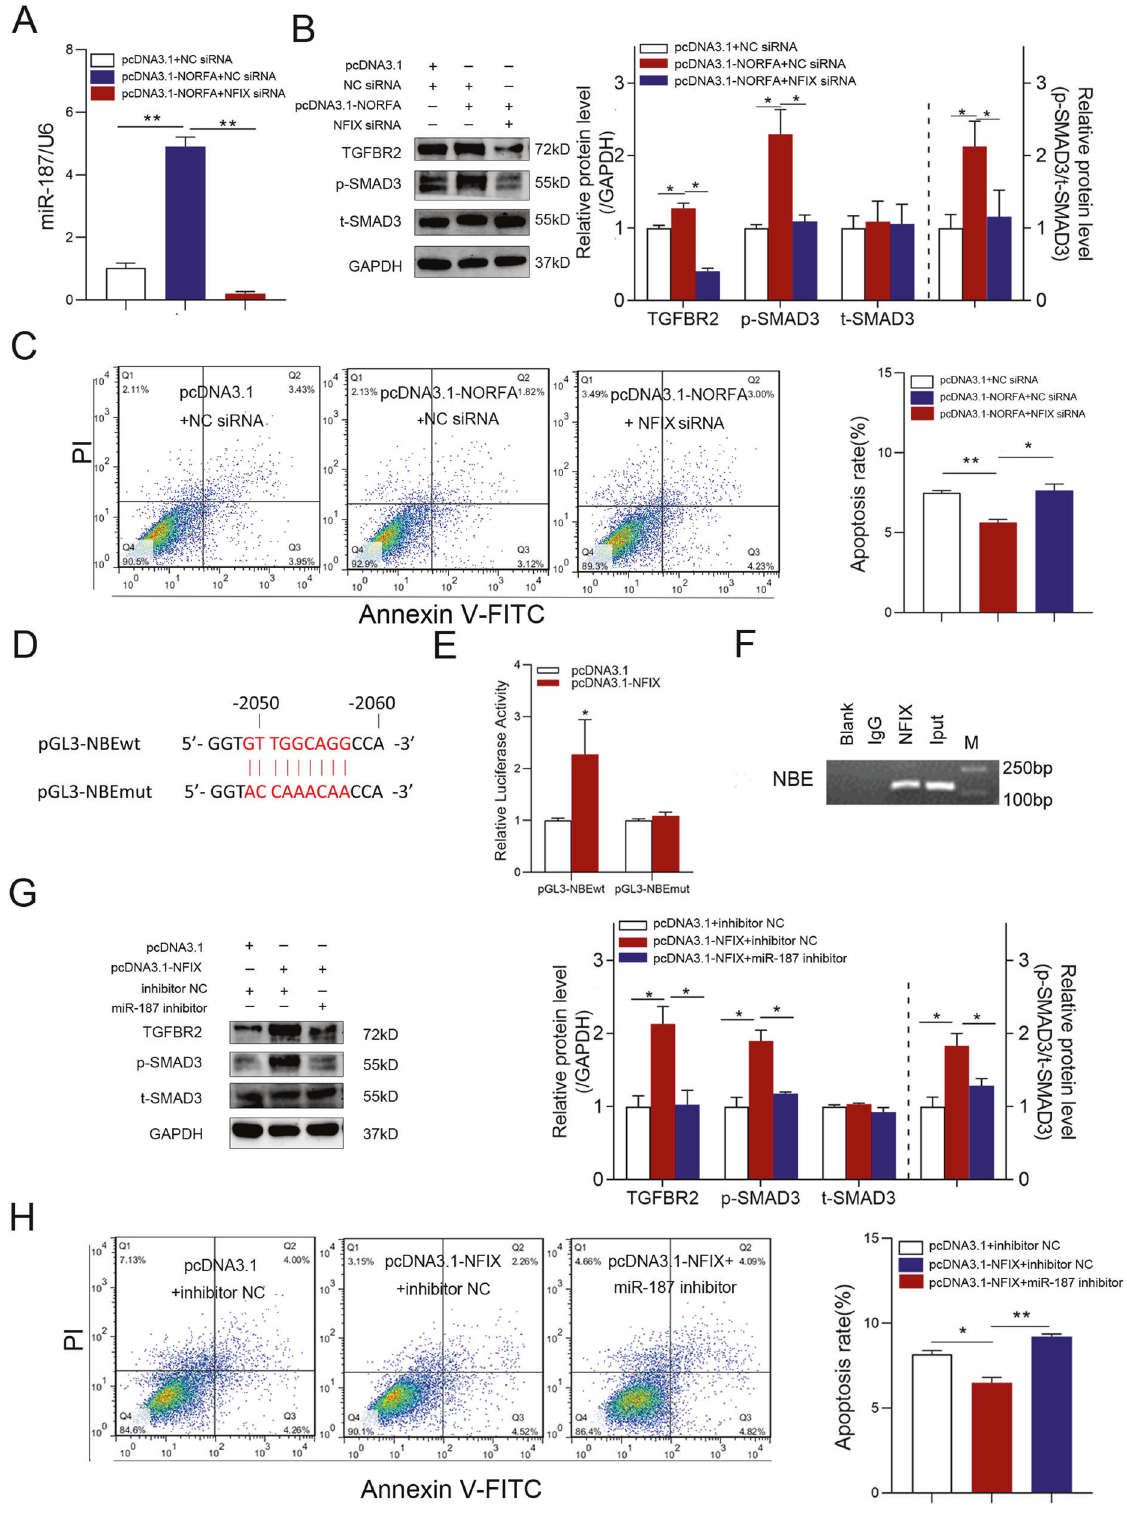
Fig. 6 NORFA regulates TGF- β signaling and apoptosis in sow GCs through an NFIX/miR-187 axis. A qPCR detection of miR-187 levels after co-transfection with pcDNA3.1-NORFA and NFIX-siRNA. B Western blot detection of TGFBR2, p-SMAD3, and t-SMAD3 protein levels after co- transfection with pcDNA3.1-NORFA and NFIX-siRNA. C FACS detection of apoptosis rate after co-treatment with pcDNA3.1-NORFA and NFIX- siRNA. D Schematic representing the reporter vectors for the miR-187 promoter containing wild-type and mutated NBE motifs. E Luciferase activity was determined in GCs co-transfection with plasmid pcDNA3.1-NFIX and pGL3-NBEwt or pGL3-NBEmt. F ChIP detection of NFIX bound to the miR-187 promoter using an NFIX-speci fi c antibody. G Western blot detection of TGFBR2, p-SMAD3, and t-SMAD3 protein levels after co-transfection with pcDNA3.1-NFIX and miR-187 inhibitor. H FACS analysis detection of apoptosis rate after co-treatment with pcDNA3.1-NFIX and miR-187 inhibitor. Data represent means ± SEM for three independent experiments. * p < 0.05; ** p < 0.01. Cell Death Discovery (2023)